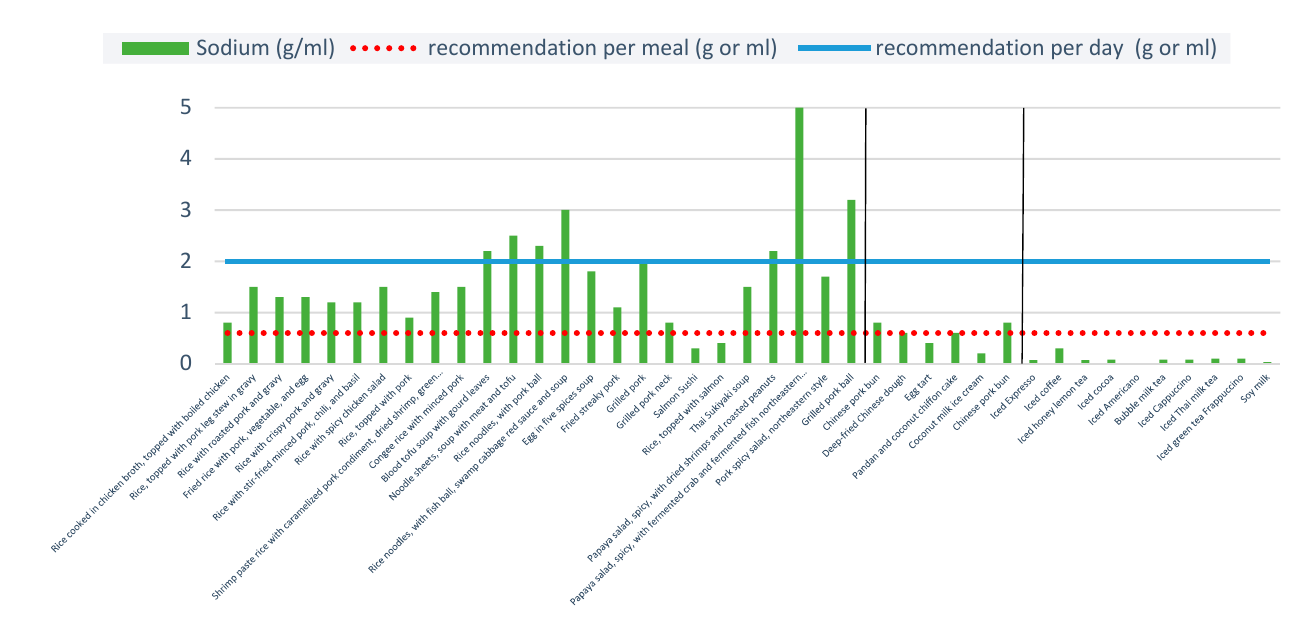
Figure 4. Total sodium content per portion of 40 menu items. Note: Two vertical blacks line sepa-